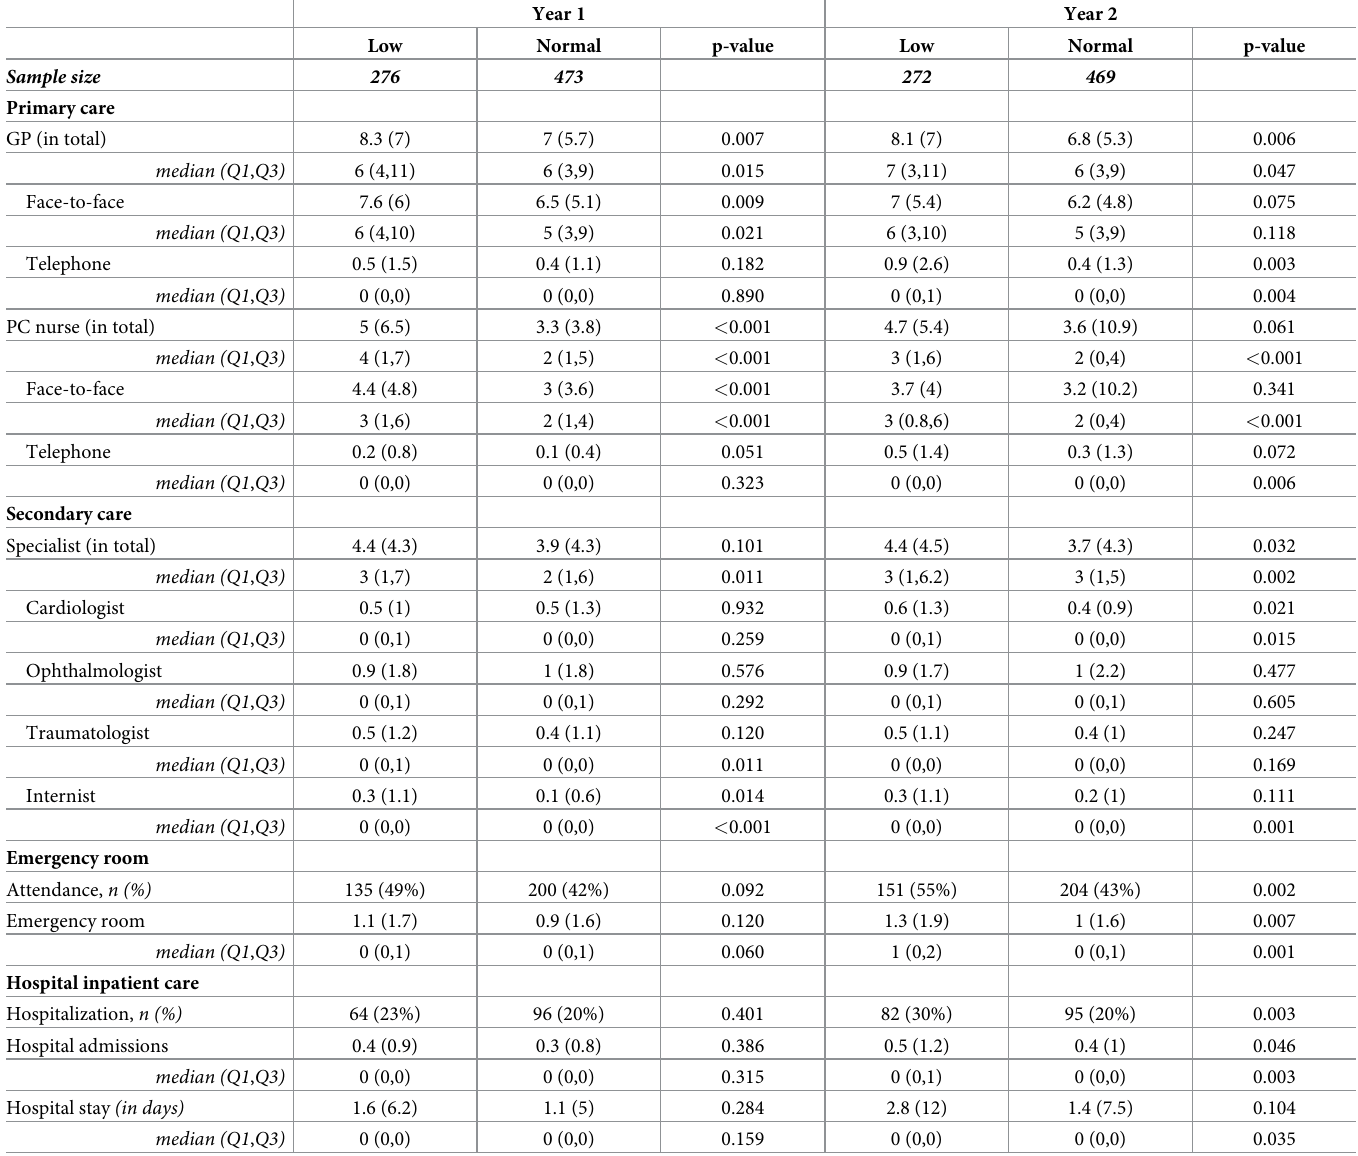
Table 2. Use of health services per year, by functional